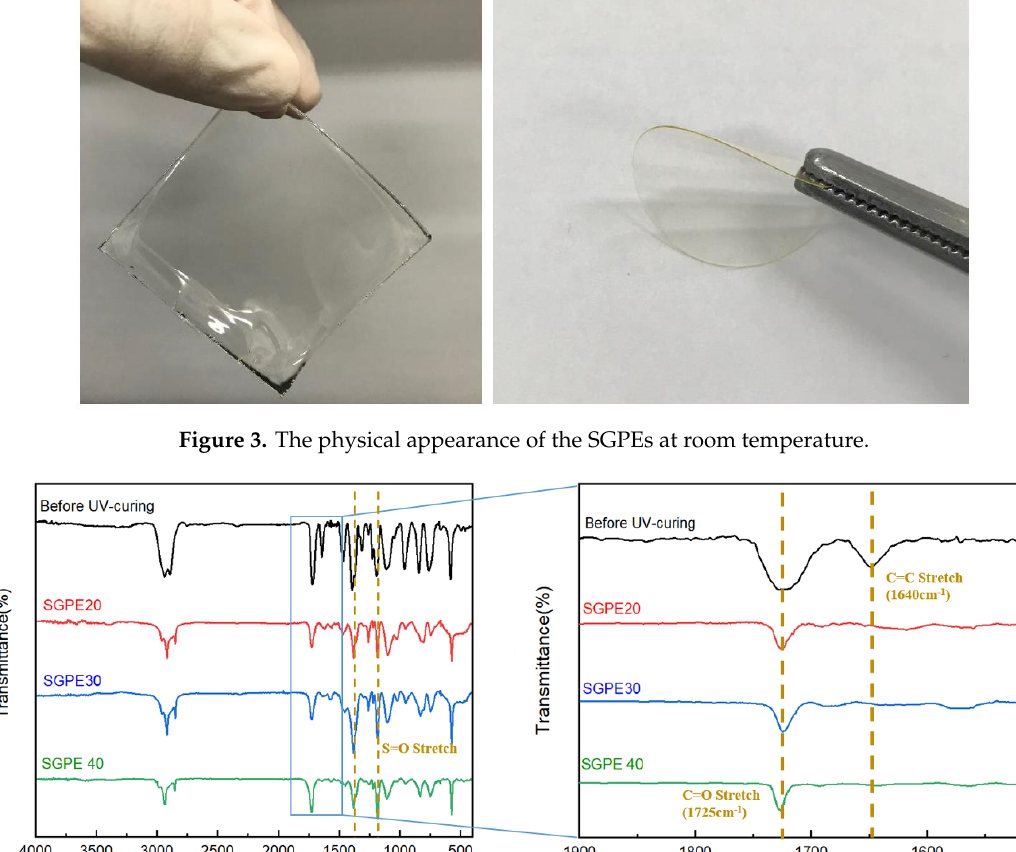
Figure 3. The physical appearance of the SGPEs at room temperature.